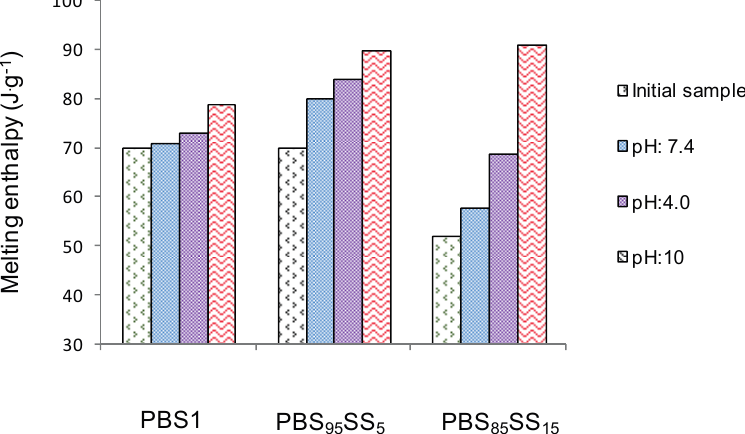
Figure 5. Melting enthalpies of PBS1, PBS 95 SS 5 and PBS 85 SS 15 after eight weeks of incubation and initial samples.